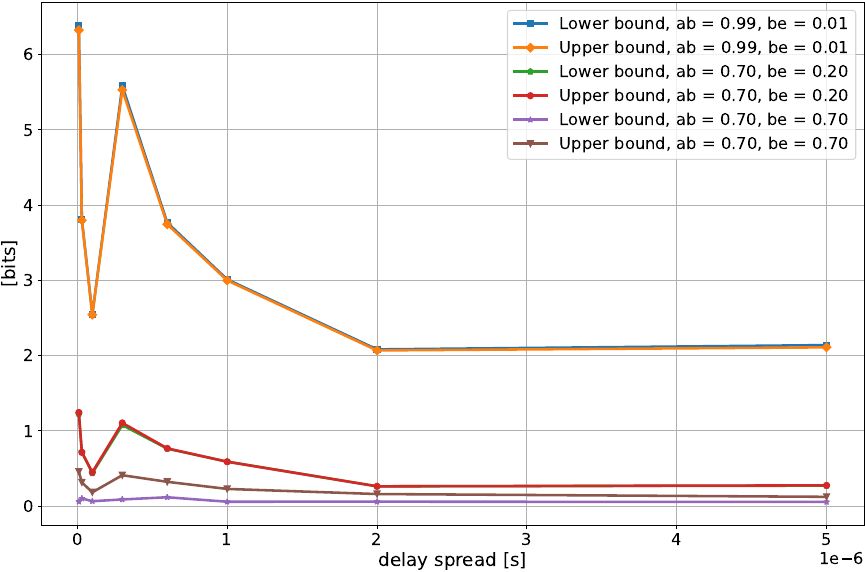
Figure 12. Secrecy key rate as a function of the delay spread of the channel of Alice and Bob, for different values of the correlation and with 1 filter. In the legend, “ab” and “be” stand for Alice–Bob correlation and Bob–Eve correlation.